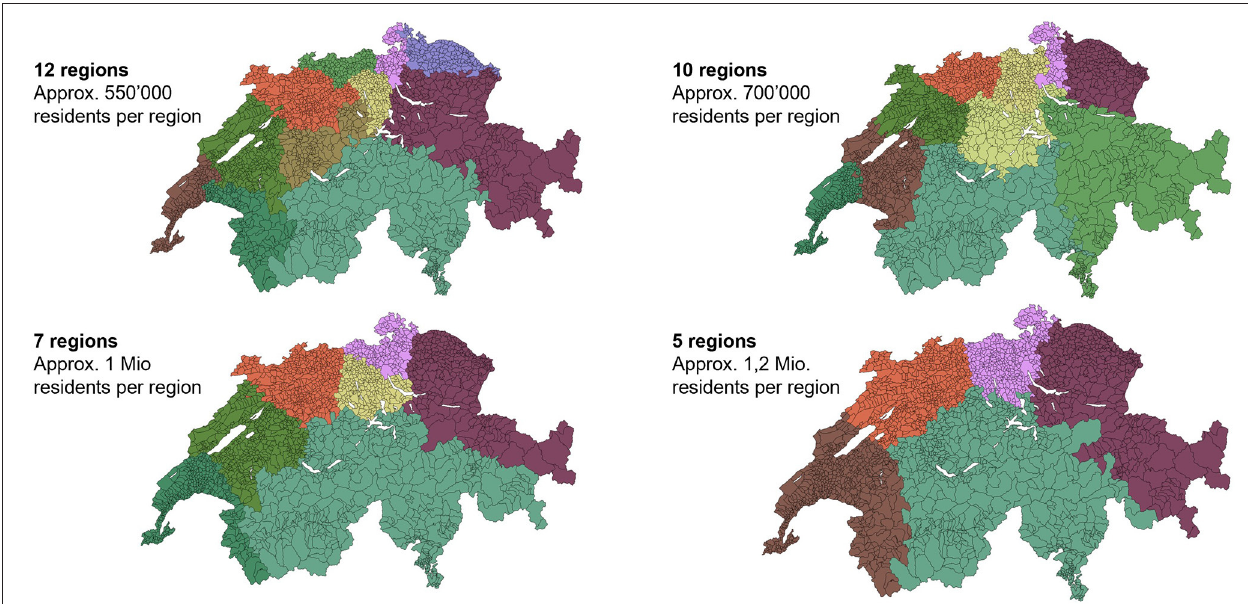
FIGURE 7 | Four alternative definitions of equal catchment areas for vaccine distribution, based on residential densities. Maps like these could guide decisions on which municipalities/cantons should work together in order to maximize the reach of residential populations. Source: analysis and illustration by authors using data source (